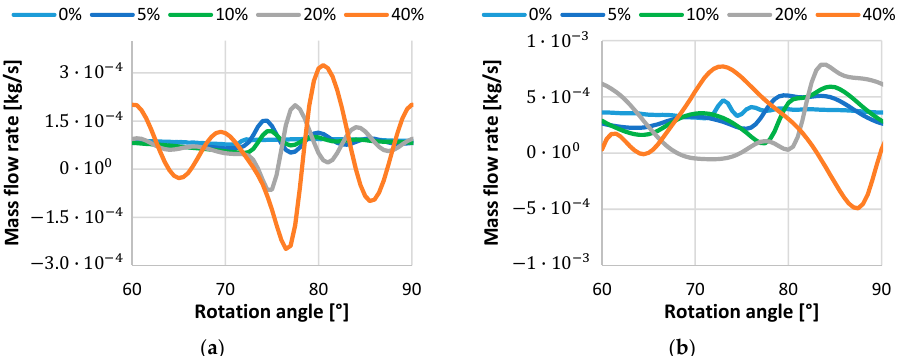
Figure 29. Influence of the IGVF of free air on the instantaneous outlet 1 mass flow rate at 5 bars, ( a ) 500 rpm and ( b ) 2000 rpm.